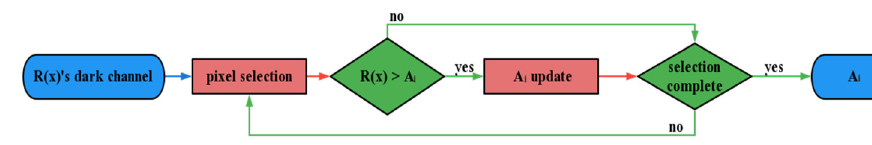
Figure 2. Estimation of atmospheric light intensity A i .